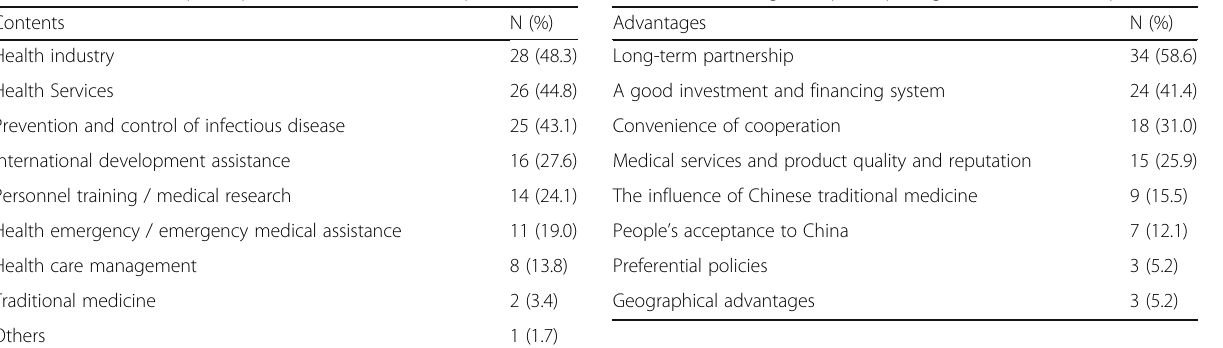
Table 4 Advantages of participating in BRI Health